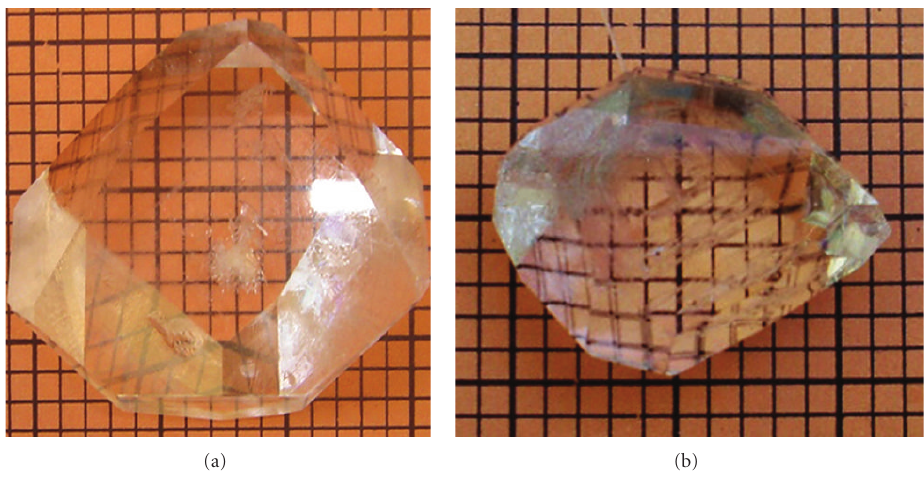
Figure 1: (a) Pure TGS (b) 1 mole % LiSO 4 -doped TGS Crystal.